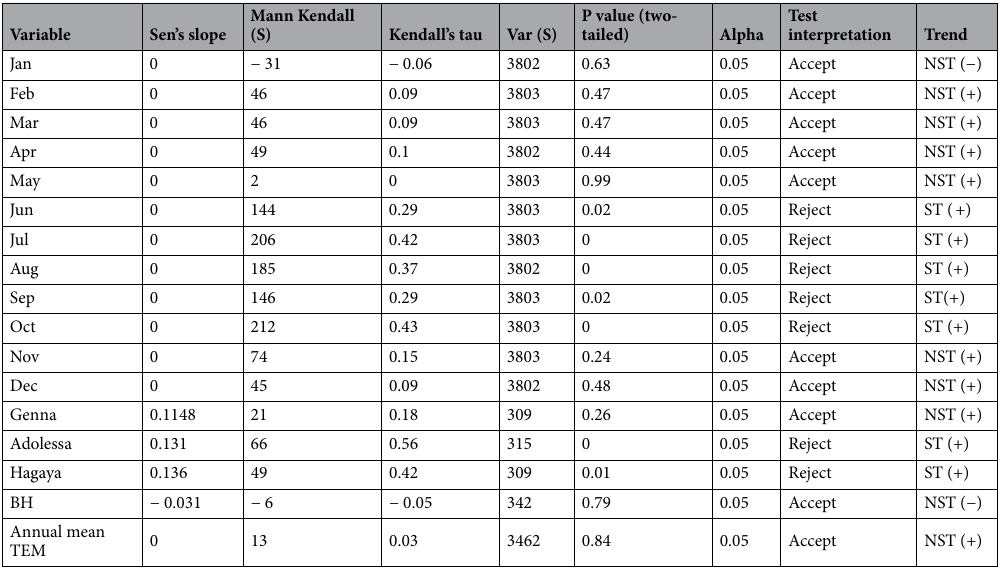
Table 6. Monthly, seasonal and annual minimum temperature MK test results for Moyale